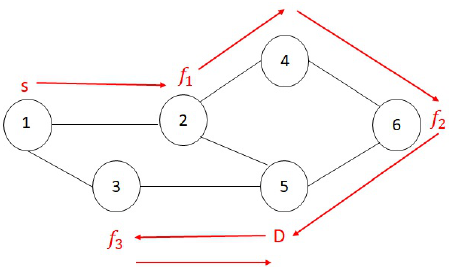
Figure 1. Random placement example.